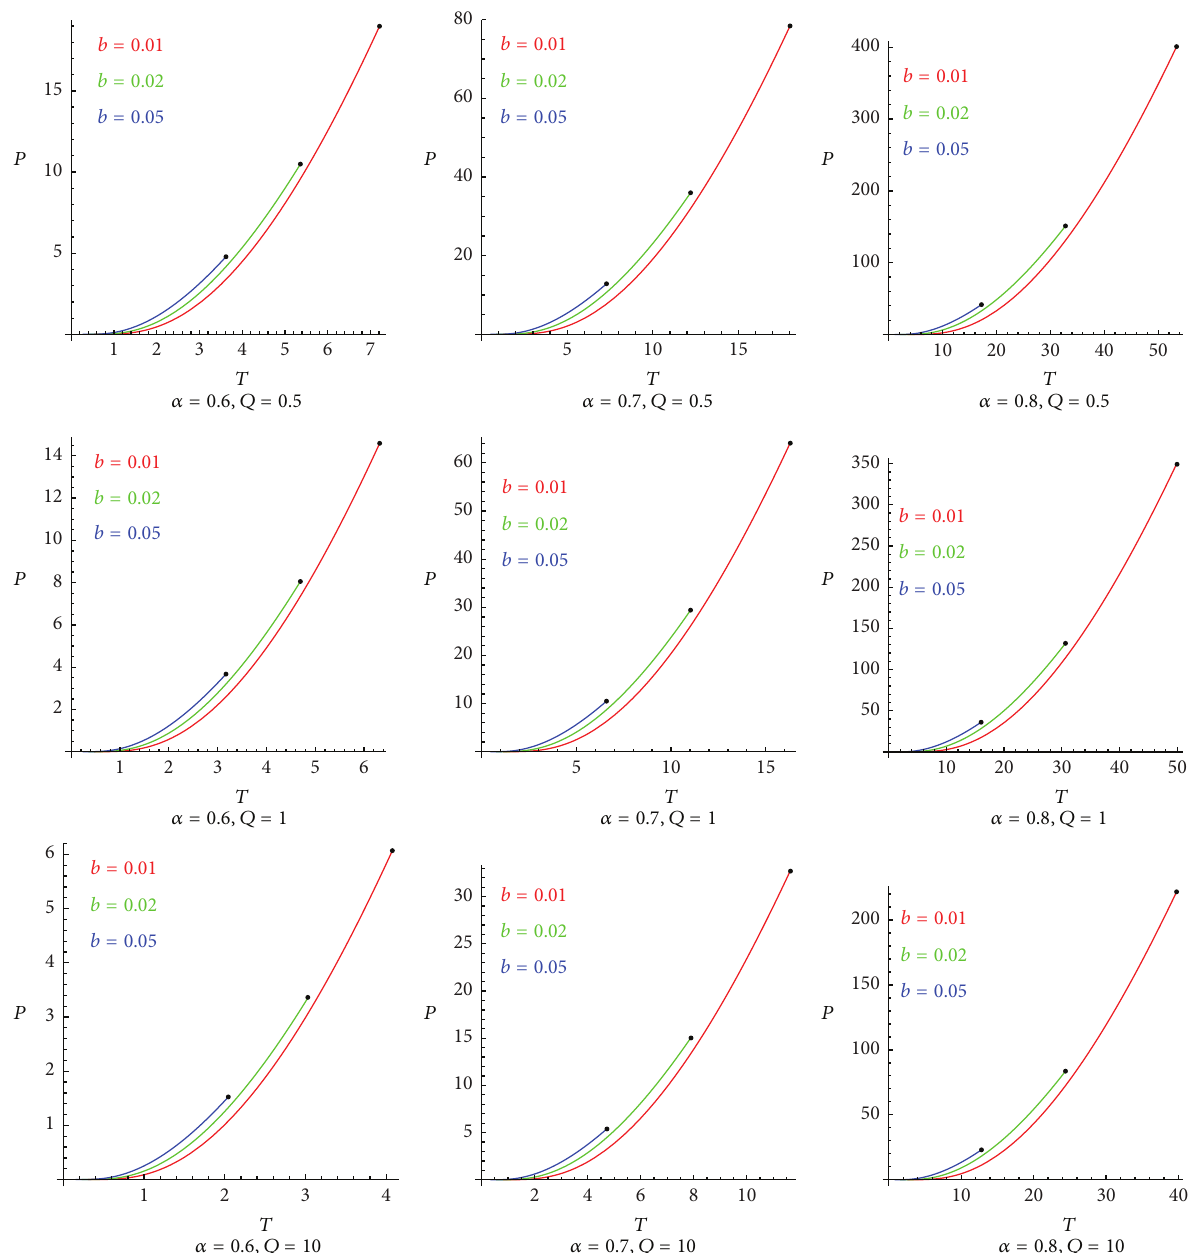
Figure 3: Two-phase equilibrium curves in 𝑃 - 𝑇 diagrams for the topological dilaton black hole in 5 -dimensional AdS spacetime. In each diagram, the longest curves (red) correspond to 𝑏 = 0.01 , the curves with medium length (green) meet 𝑏 = 0.02 , and the shortest ones (blue) are with 𝑏 = 0.05